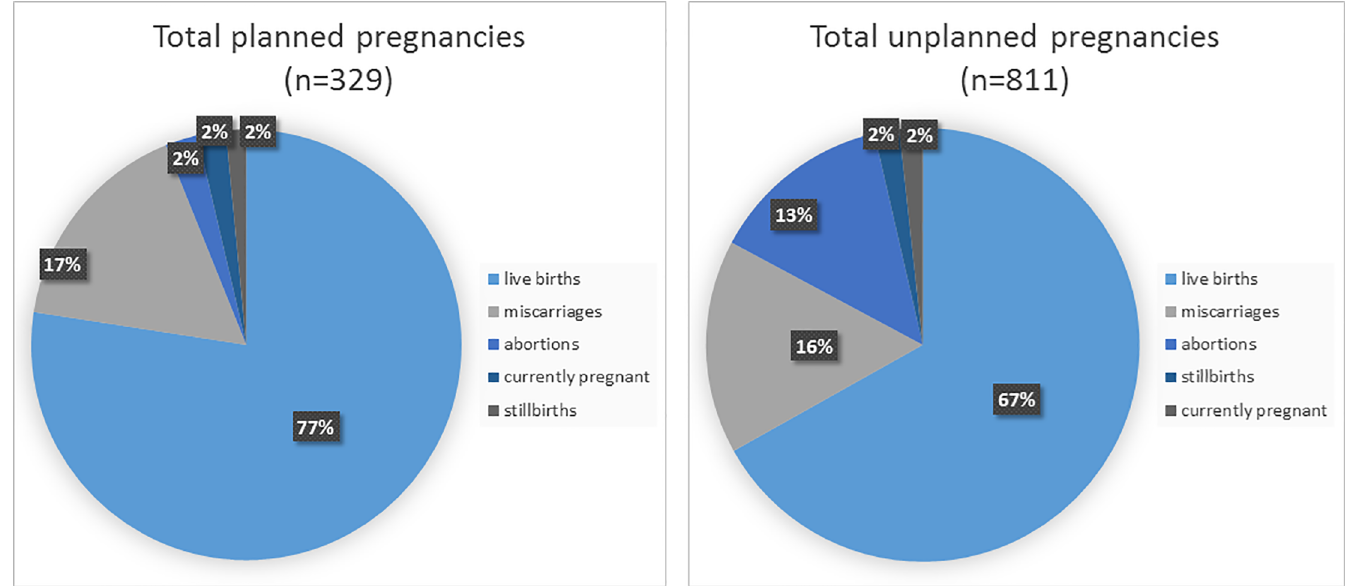
Fig 1. Percentage of each birth outcome among planned vs unplanned pregnancies, Medical Monitoring Project (n = 1,142).